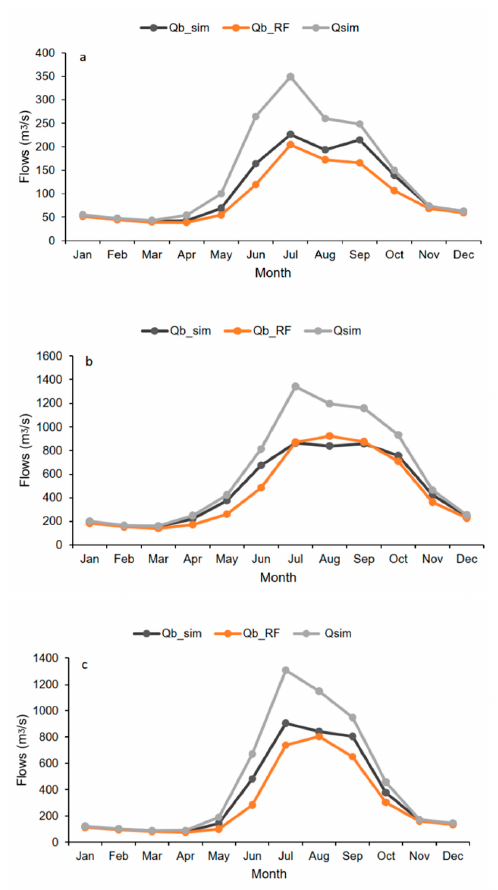
Figure 9. Comparison of baseflow simulated by HEC-HMS and the recursive digital filter (RDF) in ( a ) the SLR at Xiangda, ( b ) SYER at Tangnaihai, and ( c ) SYAR at Zhimenda. Q b_sim and Q sim are simulated baseflow and streamflow by HEC-HMS, and Q b_RF is the estimated baseflow by the RDF.